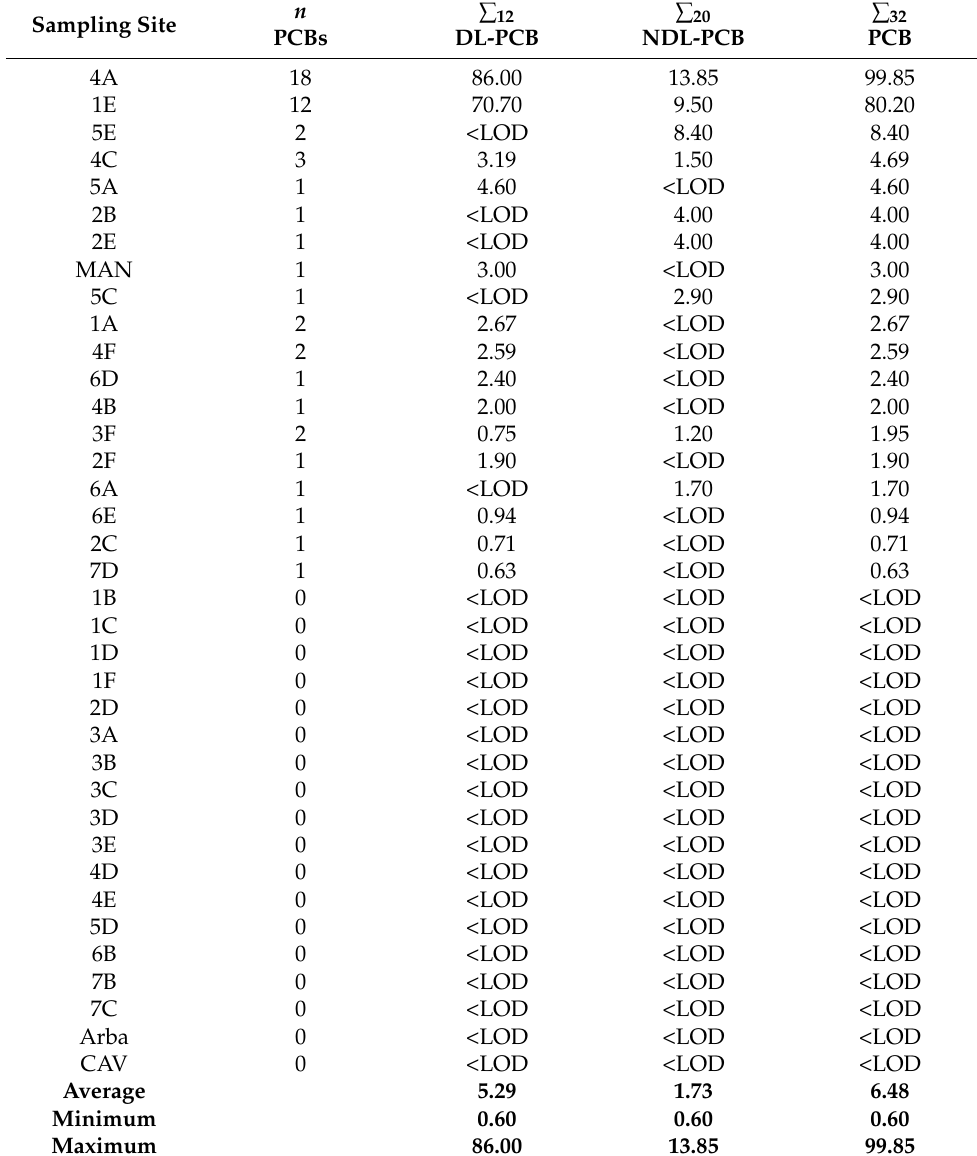
Table 1. Concentration sums ( µ g kg − 1 ) of polychlorinated biphenyls (PCBs) calculated for the Robinia pseudoacacia leaf samples collected in the 37 sampling sites shown in Figure 1; Note that samples were sorted in descending order depending on the total PCB